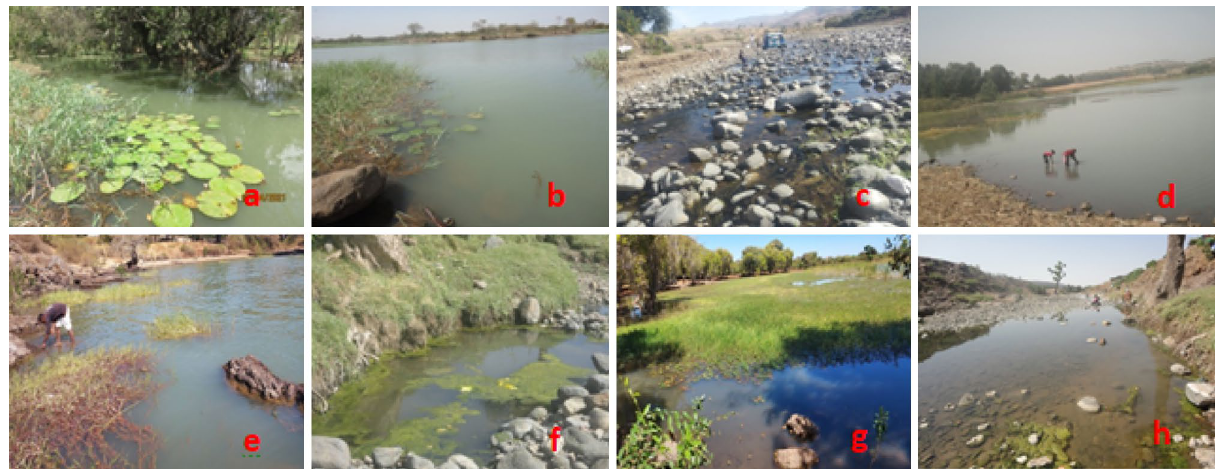
Figure 2. Image taken from some of the snail collection sites around Lake Tana; ( a ) Enferanz river ( b ) Cherechera site ( c ) Garno river ( d ) Qunzela port ( e ) Gorgora port ( f ) Shinne river ( g ) Dek Island ( h ) Robit river. All the images were taken by the corresponding author